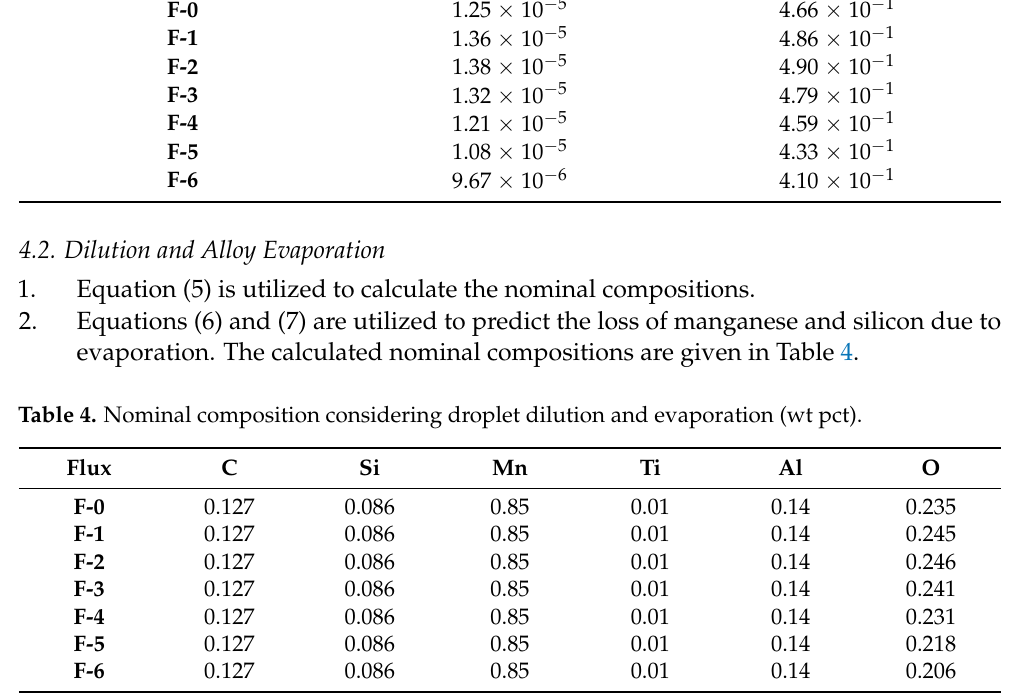
Table 3. Output of simulated P O